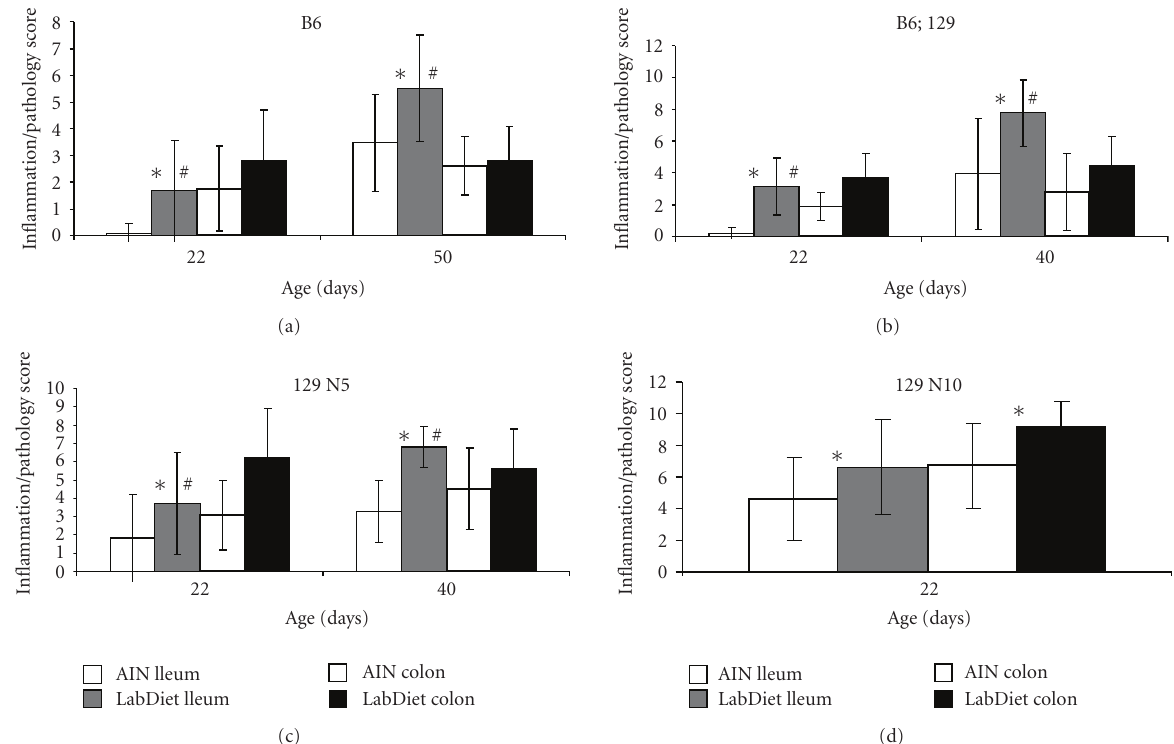
Figure 2: E ff ect of diet on ileum and colon histology at weaning and peak pathology by strain in GPx1/2-DKO mice. Mice on LabDiet or AIN diet were analyzed at 22 days of age or upon signs of morbidity, and at the peak of ileitis, which is 40 days for B6;129 or 129 N5 and 50 days for B6. 129 N10 mice were only analyzed at 22 days of age due to high morbidity. The AIN diet alleviated ileitis significantly in all strains at both 22 days of age and at peak inflammation (the “ ∗ ” sign indicates P < . 011). The ileal inflammation/pathology scores increased significantly from 22 days to peak of inflammation in all strains ( # P < . 034). A diet-associated di ff erence in colitis was only observed in 22-day-old 129 N10 pups ( ∗ P < .